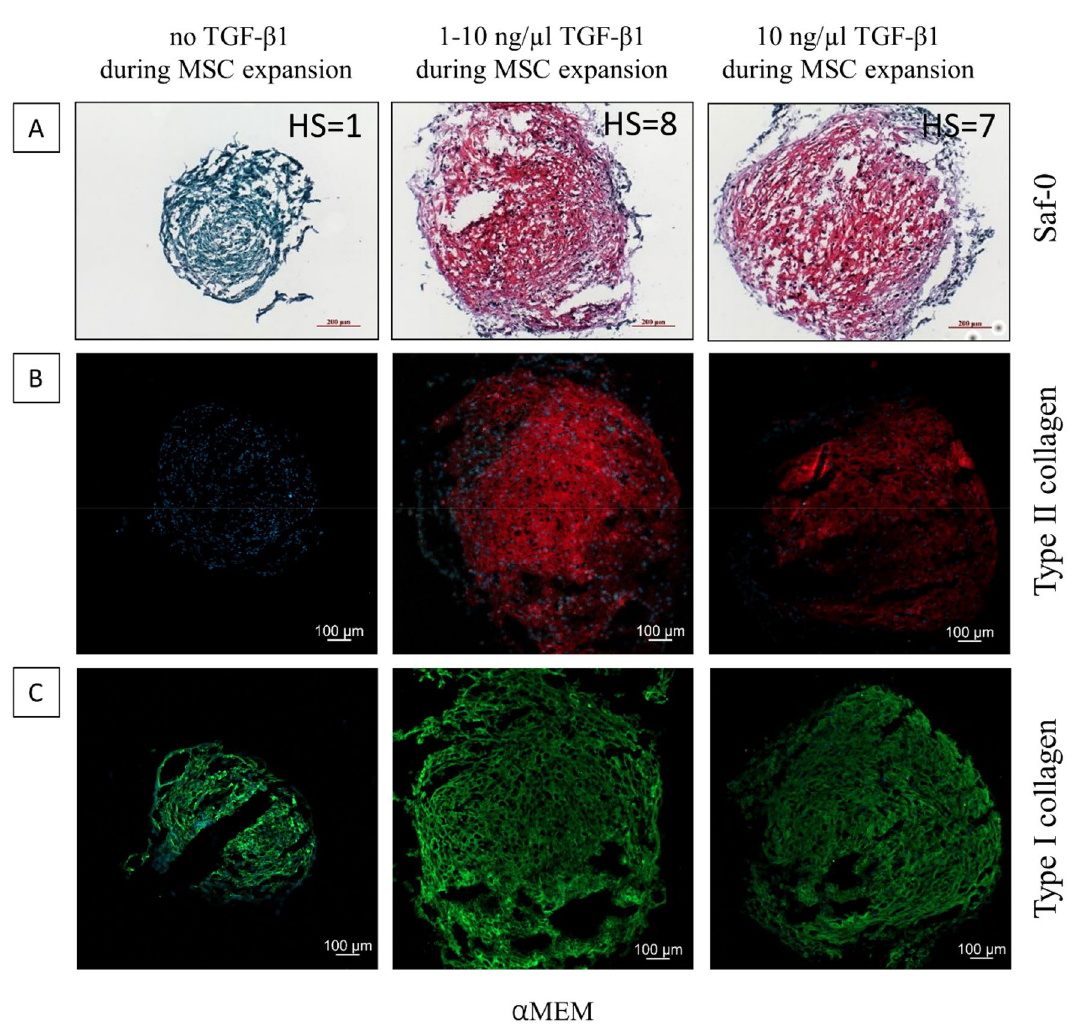
Figure 8. Representative images of Safranin-O/Fast Green staining on chondrogenic pellets of poorly responsive cells (n = 2 donors); here it is shown donor #1 ( A ). BMSCs were cultured in αMEM/FBS/FGF2 with different concentrations of TGF-β1 during cell expansion. The intensity of Safranin-O (red) staining is directly proportional to the proteoglycan content inside the pellet, while Fast Green counterstains collagen fibers. Cells in monolayer were expanded in the presence of increasing concentration of TGF-β1 (1–10 ng/ ml) or with constant 10 ng/ml of TGF-β1 before the induction of chondrogenesis. All the cells were induced to chondrogenic differentiation using the same medium containing 10 ng/ml TGF-β1. Each image includes the histological score (HS) assigned on the top right corner. Scale bar for 10 × Objective = 200 µm (bottom-right in each panel). ( B, C ) Immunohistological analysis of the chondrogenic potential of BMSCs expanded in αMEM supplemented or not with 1–10 ng/ml or 10 ng/ml TGFβ during MSC expansion. Pellet cryosections stained for type II ( B ) and type I ( C ) collagen. The intensity of staining is directly proportional to the collagen content, while DAPI (blue) stains cell nuclei. Scale bar (bottom left in each picture) = 100